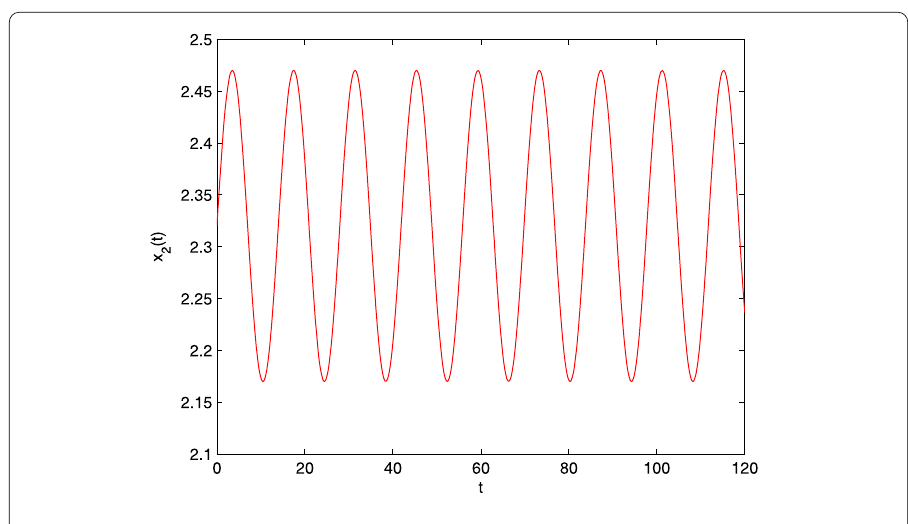
Figure 2 State trajectories of system (4.1) for x 2 ( t